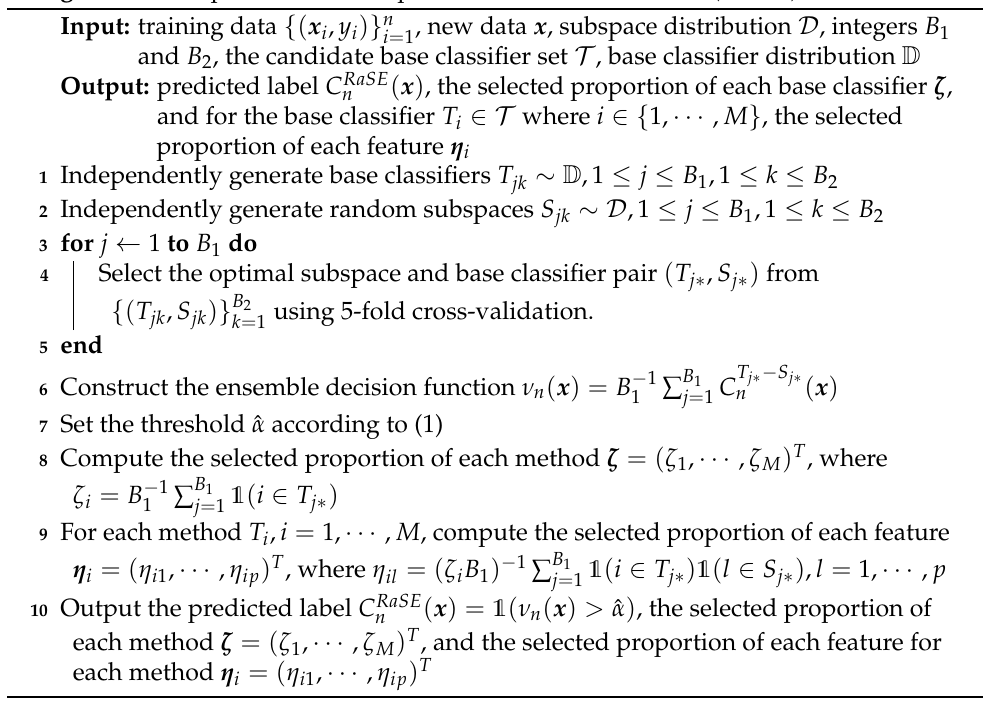
Algorithm 1: Super random subspace ensemble classification